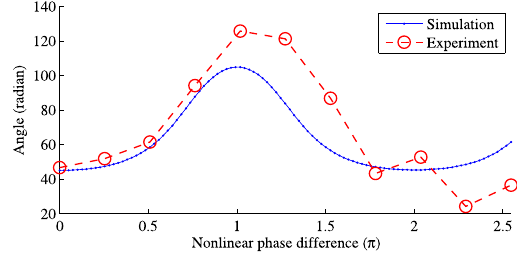
Figure 7. NFT phase difference between Λ 1 and Λ 2